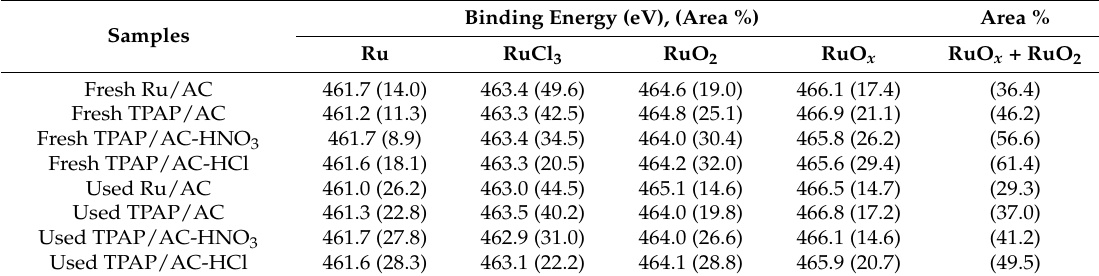
Table 3. The relative content and binding energy of ruthenium species in the fresh and spent catalysts.